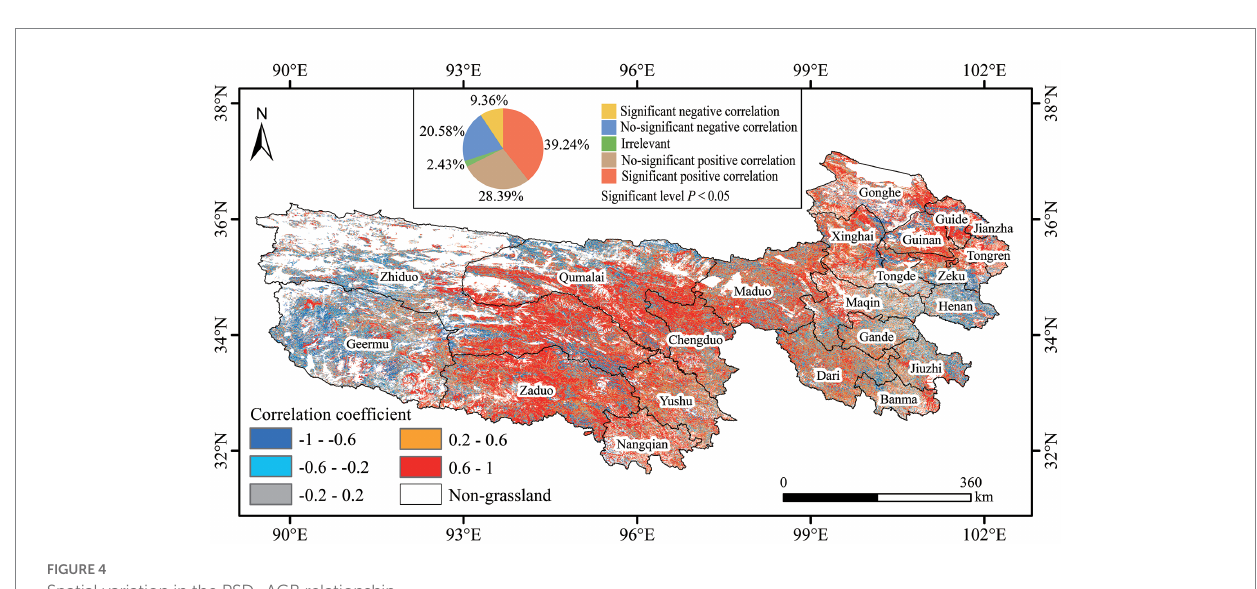
FIGURE 3 PSD and AGB spatial distribution map.